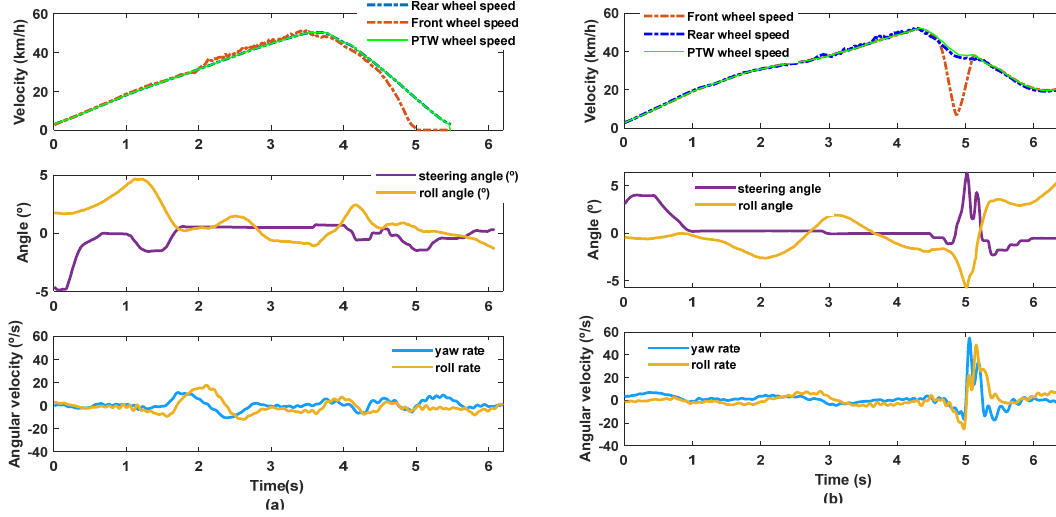
Figure 3. Example of braking trials: ( a ) full control case; ( b ) loss of control case.